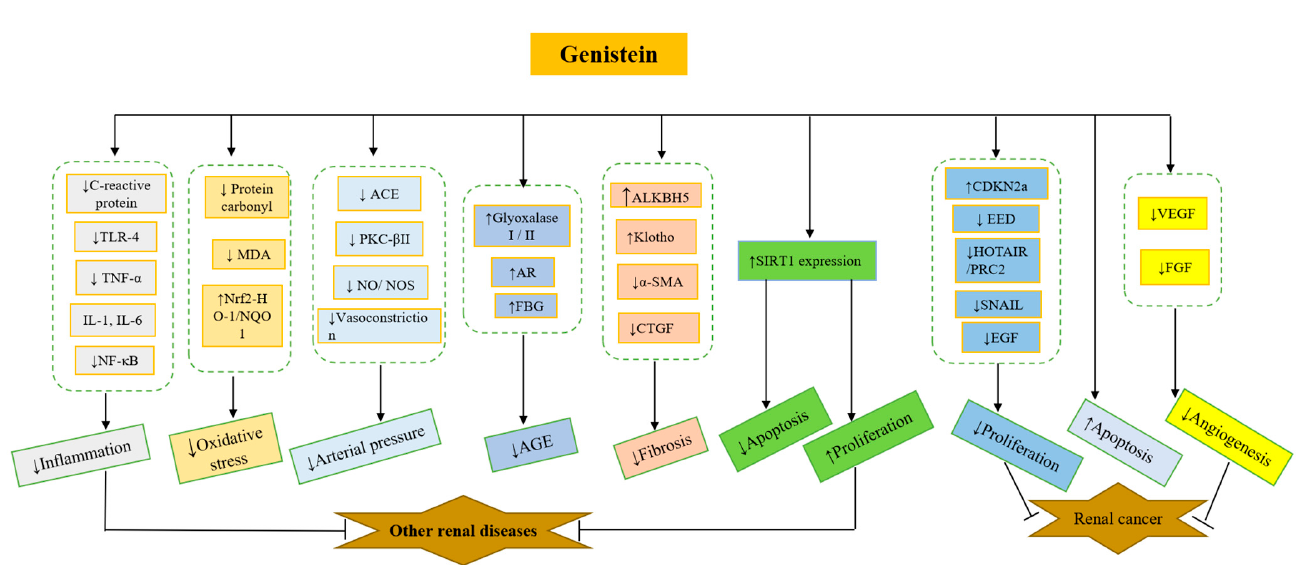
Figure 4. The mechanism of genistein actions in kidney. TLR-4: Toll-like-receptor-4, TNF- α :